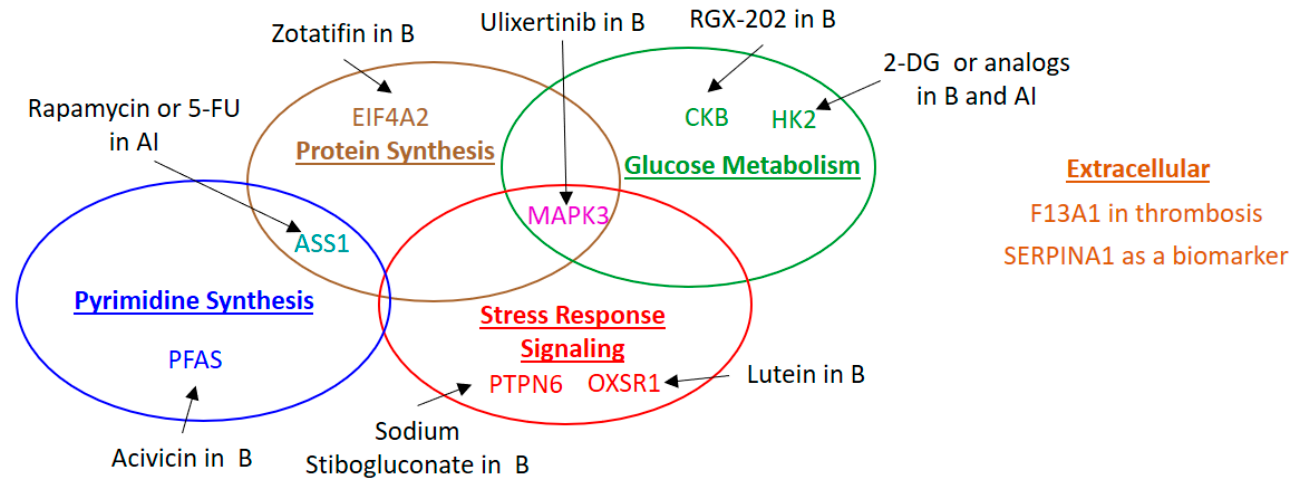
Figure 5. Illustration of functions and available drugs or drug candidates for identified targetable proteins.